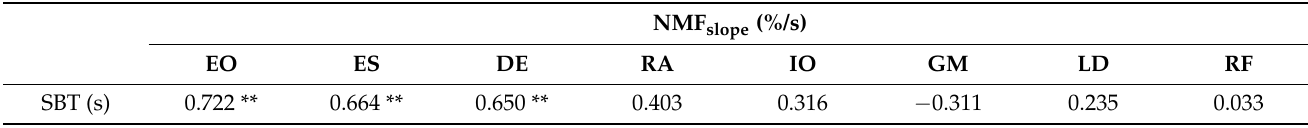
Table 3. Correlations between the normalized median frequency slope (NMF slope ) of each muscle and the side bridge test endurance time (SBT).